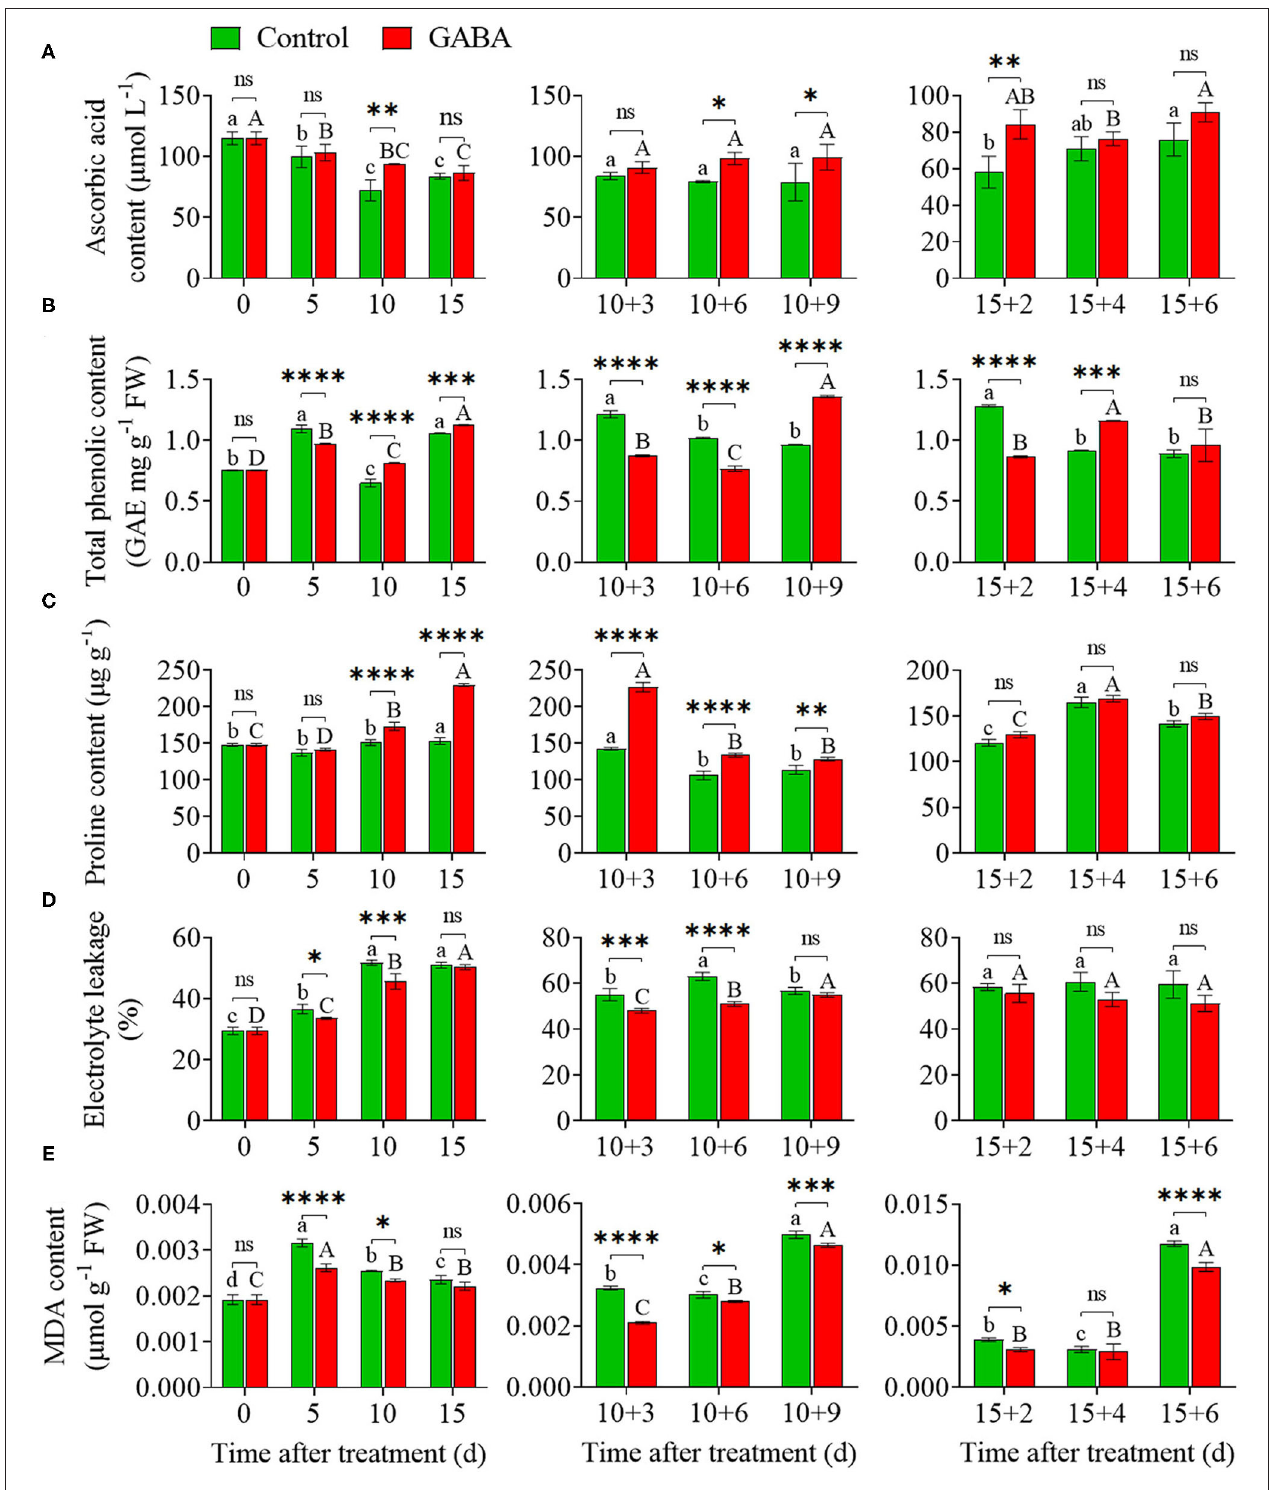
FIGURE 4 | The content of ascorbic acid (A) , total phenol (B) , and proline (C) , electrolyte leakage (D) , and malondialdehyde content (MDA) content (E) of carambola fruit during storage at 4 and 25 ◦ C. Error bars are expressed as means ± SD (standard deviation) of three replicates ( n = 3). The asterisks indicate statistically significant differences between treatments at * p < 0.05, ** p < 0.01, *** p < 0.001, **** p < 0.0001, ns, not significant.